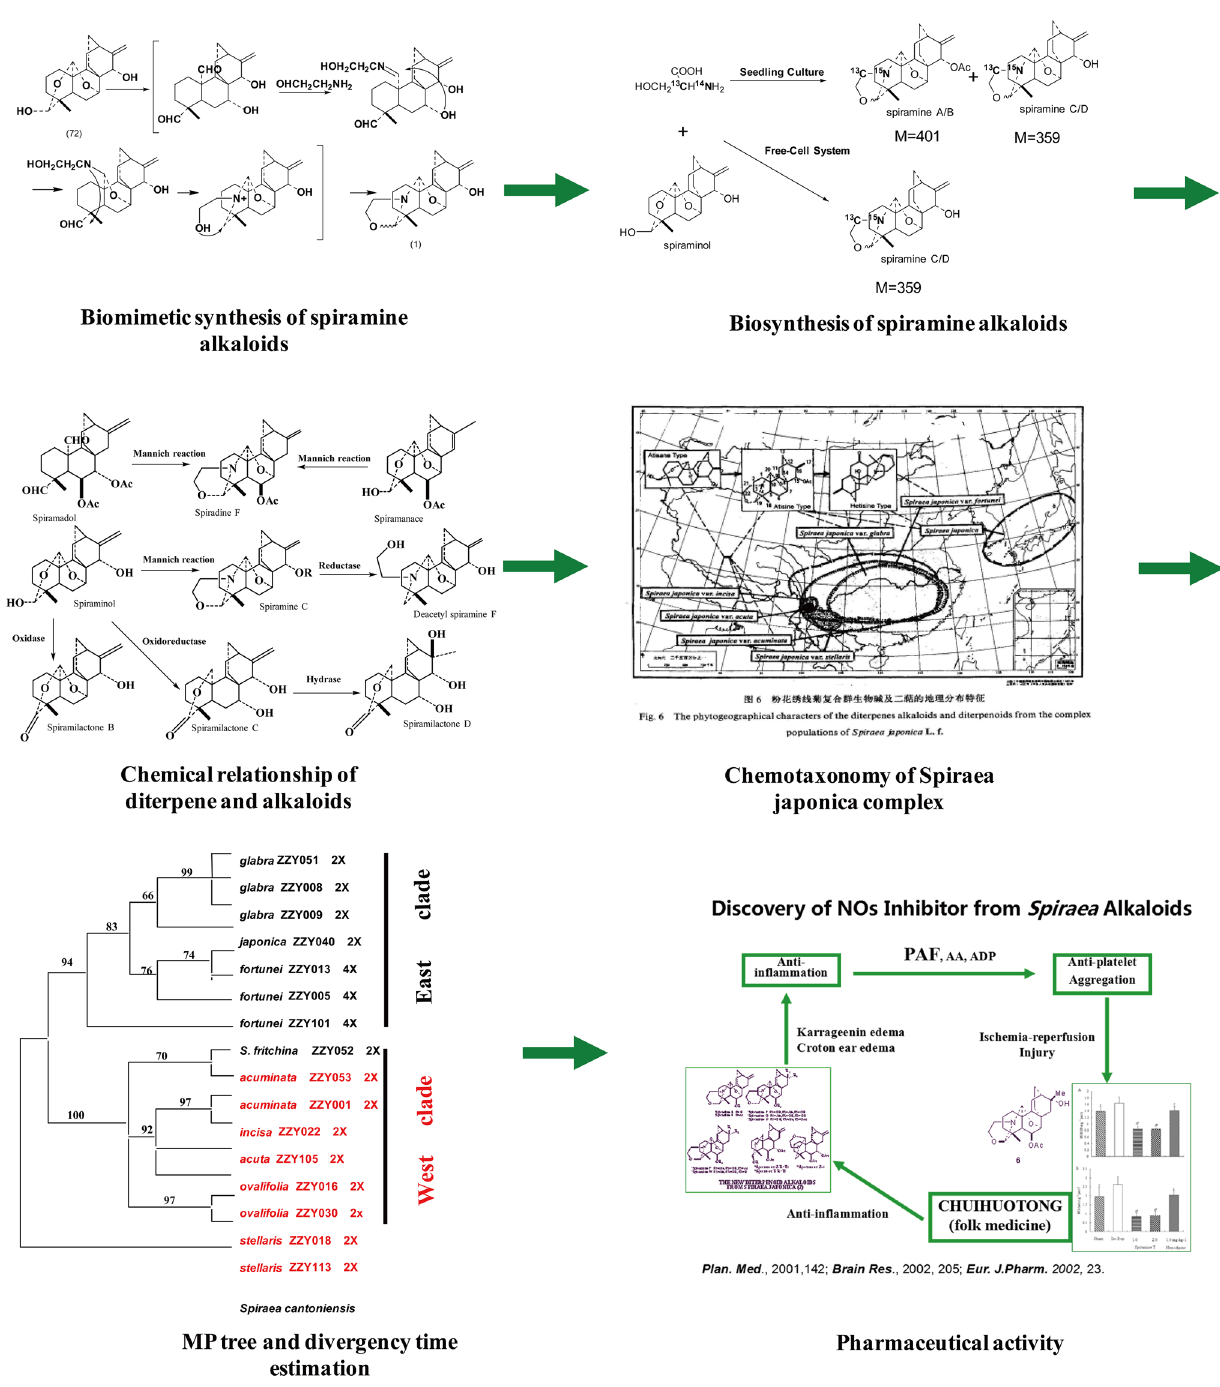
Fig. 2 Chemical and biological studies reveal a phytochemical geographic feature of the Spiraea japonica